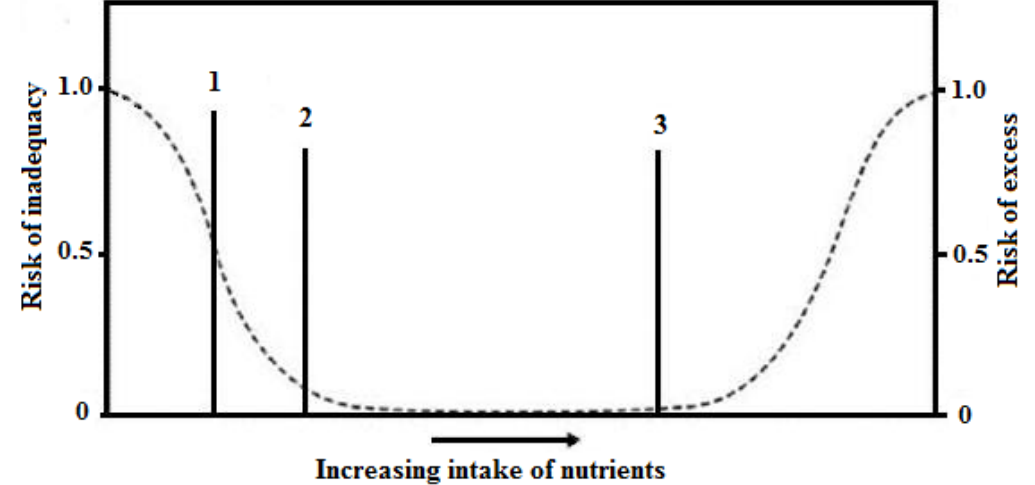
Figure 1. Graph of Nutrient intake values and the risk of nutrient inadequacy or excess a . This image shows: (1) Average Nutrient Requirement (ANR); (2) Individual Nutrient Level (INL ); and (3) Upper Nutrient Level (UNL). a Adapted from : Institute of Medicine. Dietary x Reference Intakes: The Essential Guide to Nutrient Requirements ; National Academy